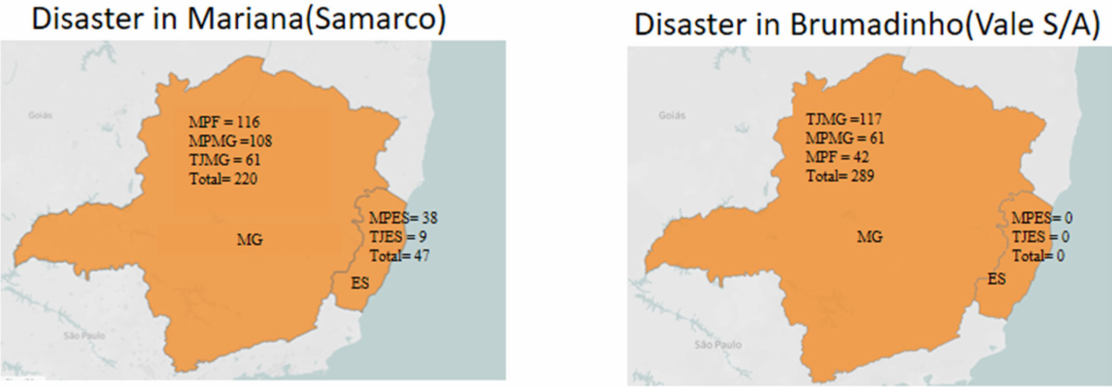
Figure 2. Number of reports of the disasters in Mariana and Brumadinho (source: